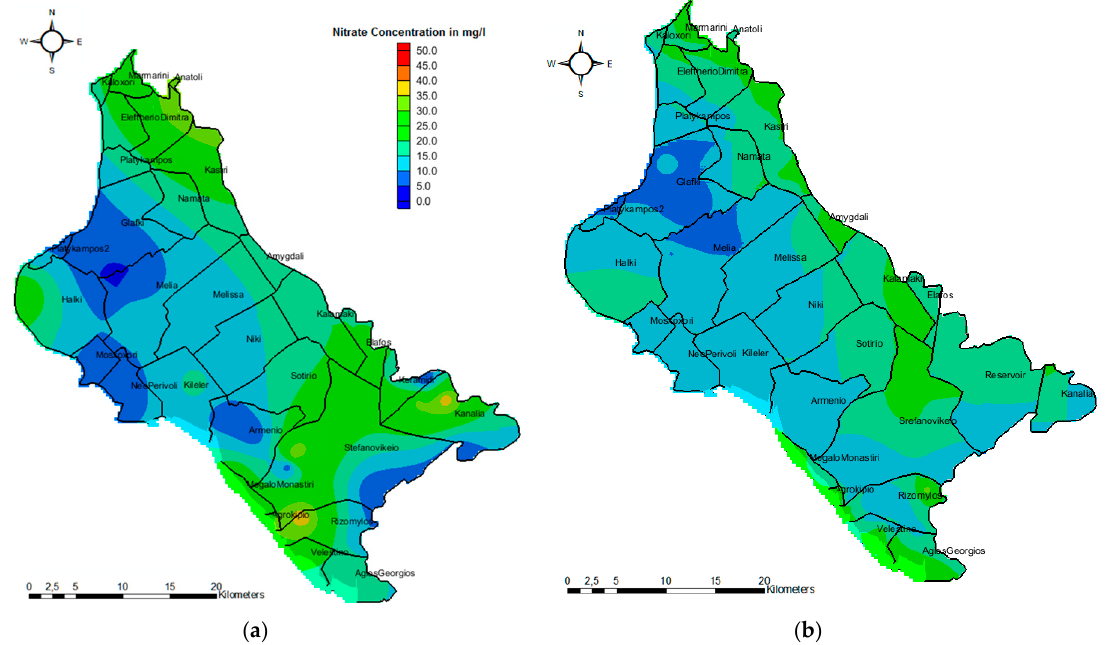
Figure 6. ( a ) records the nitrate concentration in the no reservoir scenario; Conversely ( b ) indicates the nitrate concentration in the reservoir